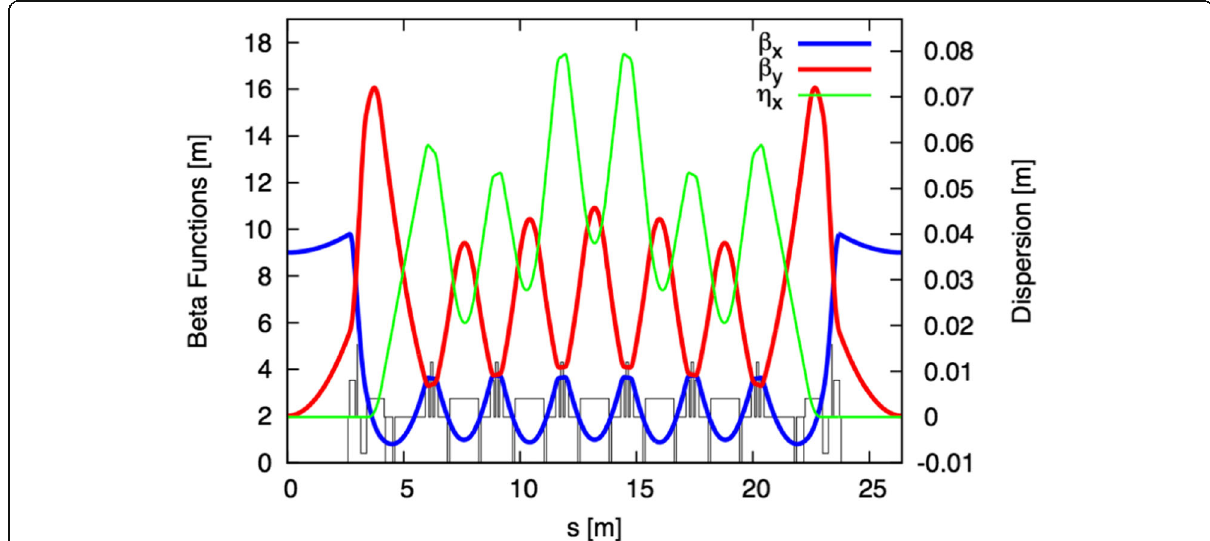
Fig. 10 Classical multi-bend achromat lattice